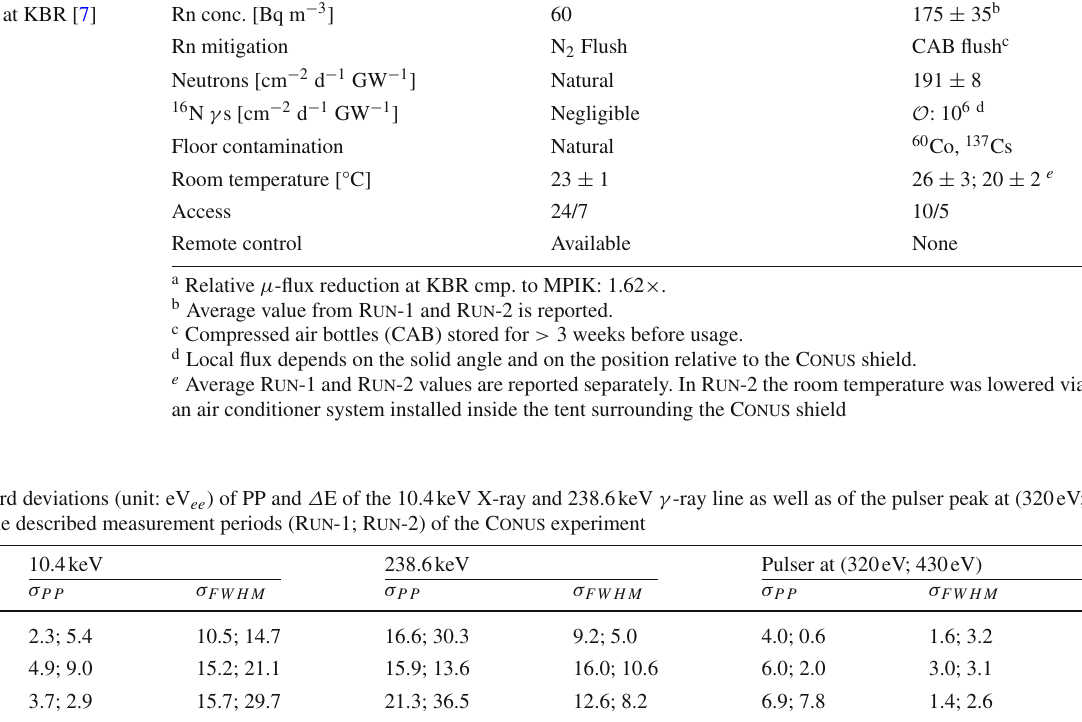
Parameter Underground lab. at MPIK Room A408 at KBR conditions and typical environmental parameters at the Overburden [m w.e.] MPIK underground laboratory [10,71] and at the Conus experimental site at KBR [7]